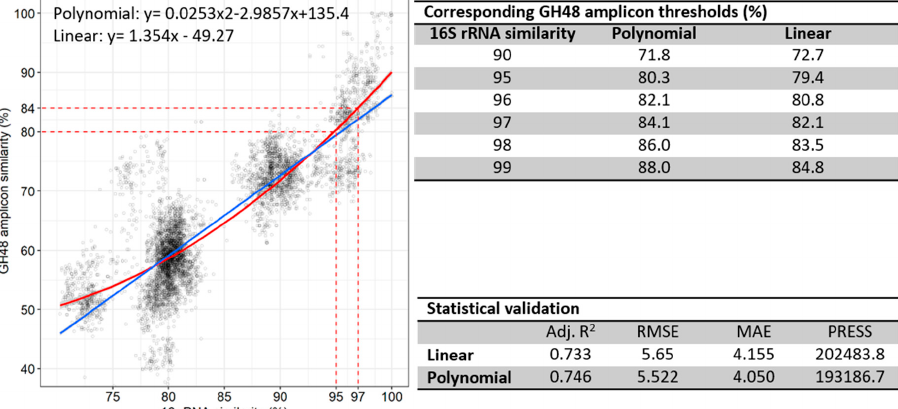
Figure 1. GH48 thresholds corresponding to 16S rRNA gene sequence similarity determined from 113 amplicons and full-length 16S rRNA gene sequences extracted from complete genome assemblies (GH48-16S-C subdataset). The corresponding GH48 sequence similarity to 16S rRNA similarities data were plotted by fitting a polynomial model (red) and a linear model (blue). To evaluate the modeling, adjusted R 2 , root-mean-square error (RMSE), mean absolute error (MAE) and predicted residual error sum of squares (PRESS) are shown.